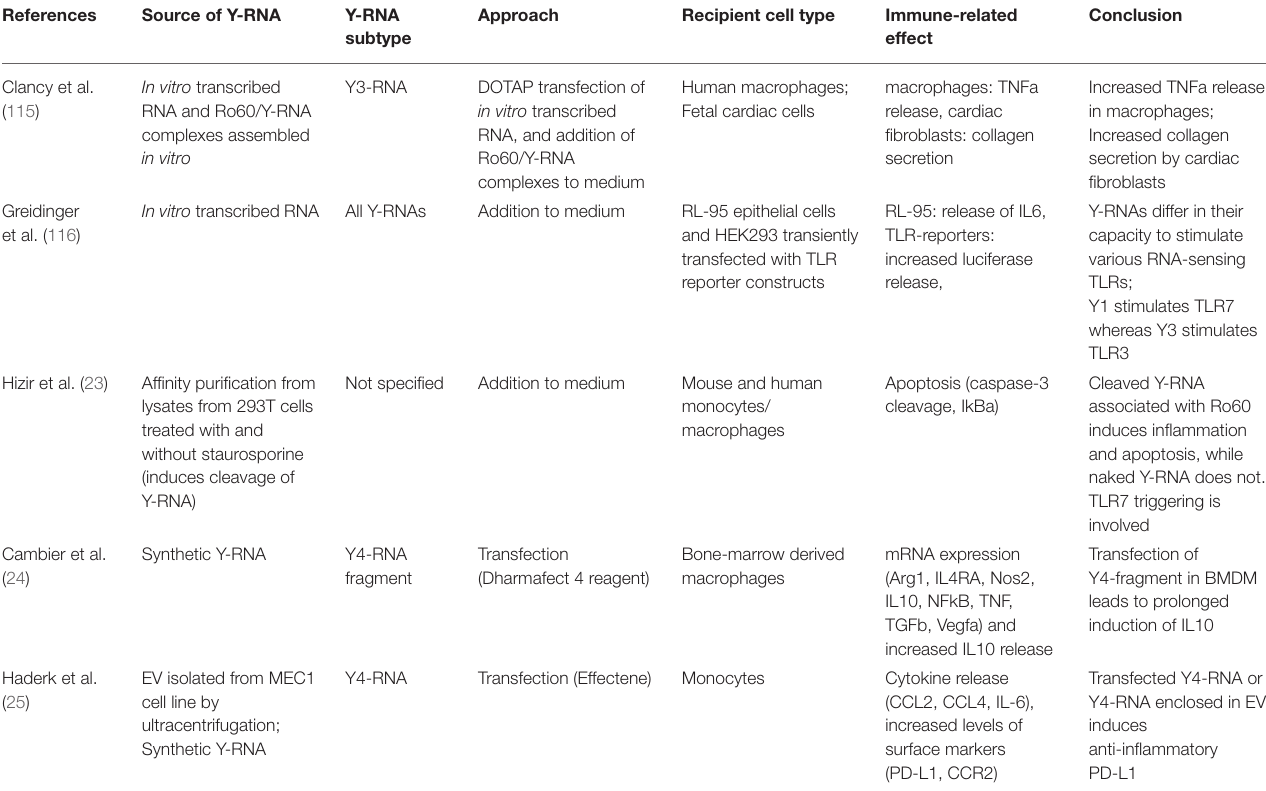
TABLE 4 | Overview of immune-related effects of extracellular